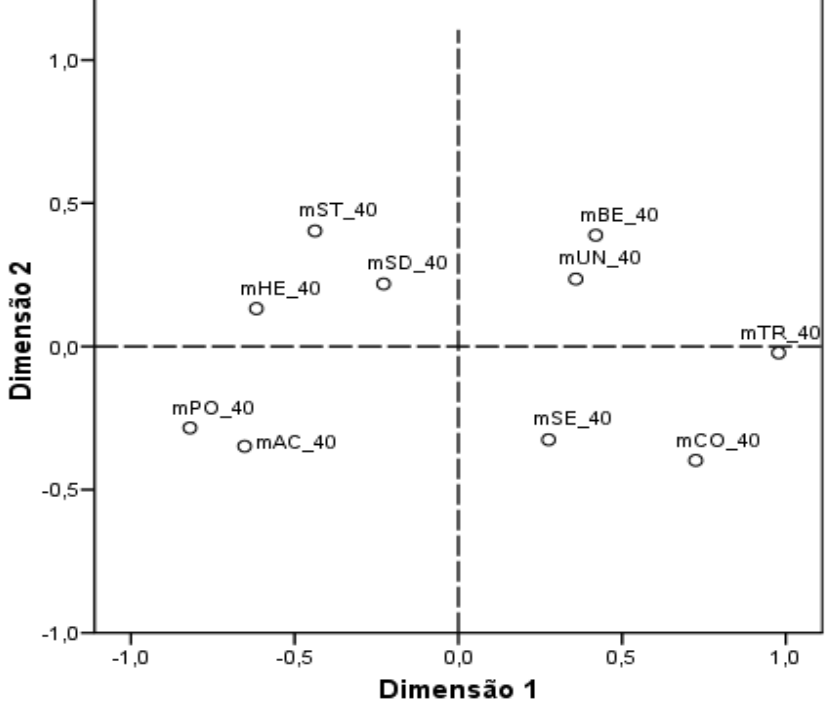
Figura 5. WCMDS por tipo motivacional –